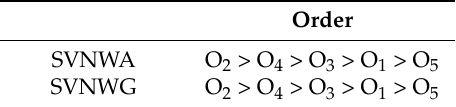
Table 6. Order of the strategic